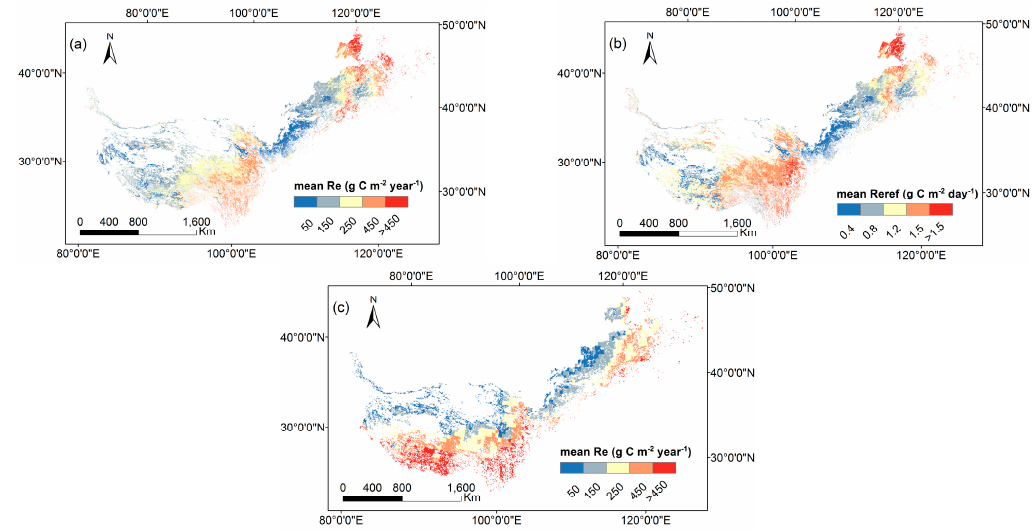
Figure 7. Predicted spatial distribution of the mean annual ecosystem respiration (RE). ( a ) and the reference respiration ( Reref ); ( b ) by our model and mean annual RE by CLM4CN; ( c ) in northern China’s grasslands.